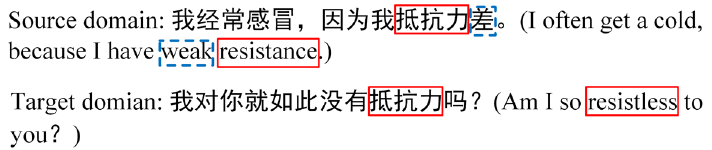
Figure 1. Example of domain-invariant and domain-specific. The sentiment expressions marked by red lines are virus domain-specific, while the broken blue lines marked domain-invariant.